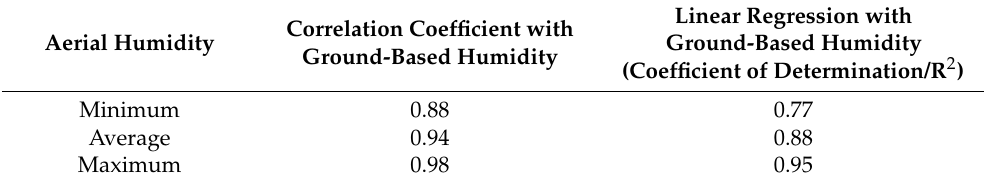
Table 4. Aerial humidity correlation coefficient and linear regression with ground-based